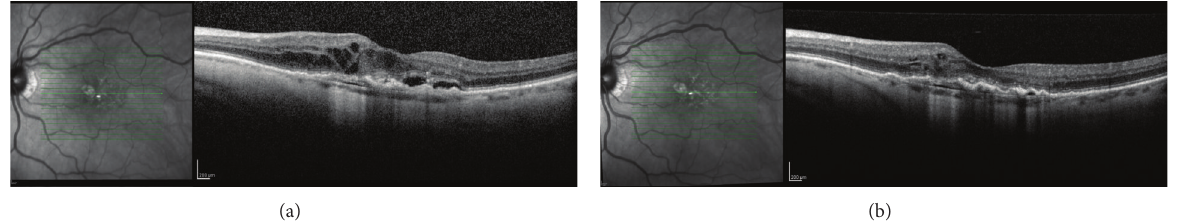
Figure 1: A patient with AMD previously treated with 14 ranibizumab injections and 13 bevacizumab injections shows persistent multilayer fluid on OCT (a). Following three aflibercept injections (b) there was marked reduction in total fluid volume as well as a reduced CRT, 3.43 to 3.07 mm 3 and 405 to 293 𝜇 m, respectively.